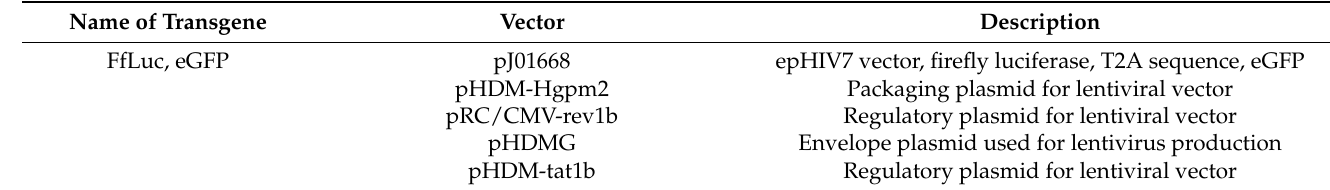
Table 1. Plasmids used in the